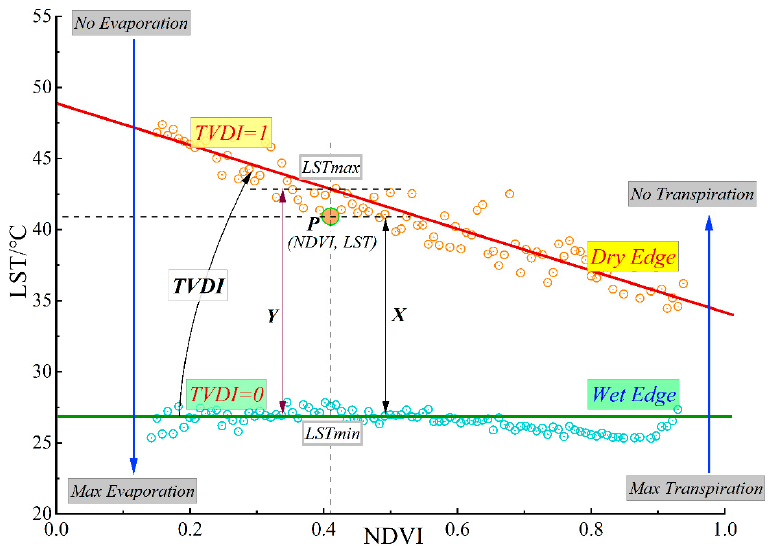
Figure 3. Definition of the Temperature Vegetation Drought Index (TVDI) and the geometric meaning of a given pixel P. Red and green circles: The maximum and minimum values ( LSTmin , LSTmax ) of LST corresponding to each NDVI pixel. Red and green lines: Dry edge and wet edge obtained from linear fitting according to all LSTmax and LSTmin . Table 3. Different levels of the Temperature Vegetation Drought